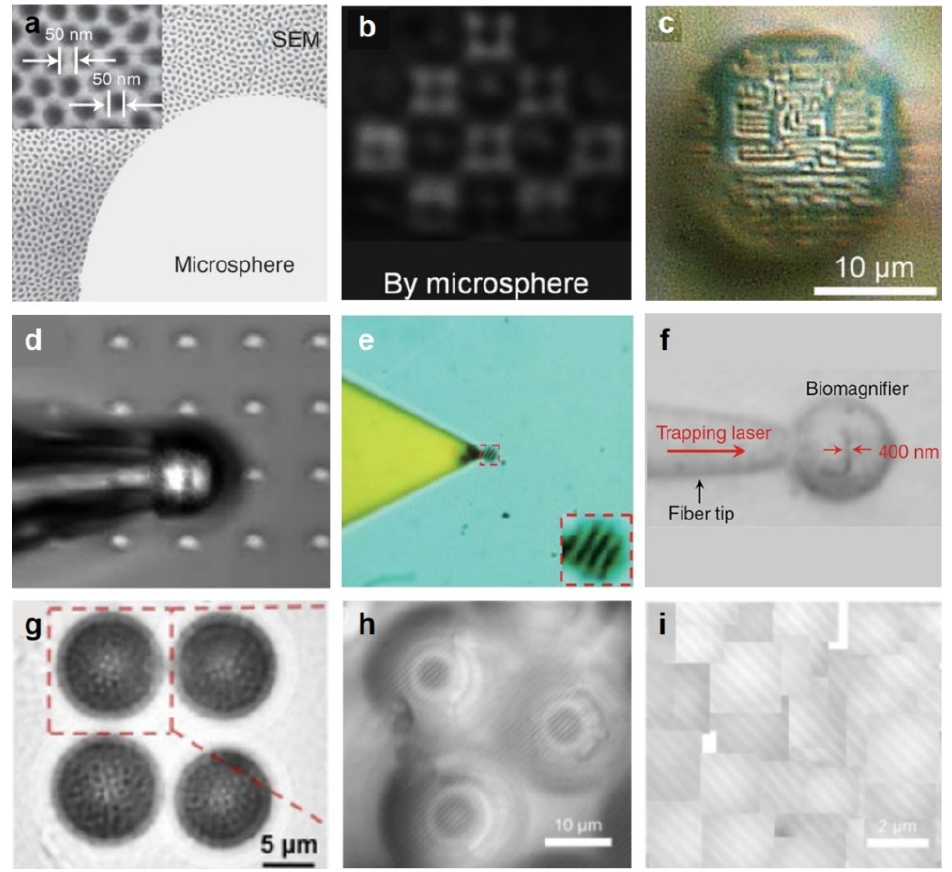
Figure 7. Optical imaging of nanostructures with microspheres. ( a ) SiO 2 microspheres on gold-plated porous anodic aluminum oxide film; ( b ) BaTiO 3 microspheres on nano-plasma samples with a gap of 50–60 nm; ( c ) TiO 2 microsphere superlenses on 60 nm wafers; ( d ) Magnified image of gold splitting square nanostructures imaged using microspheres combined with micropipettes; ( e ) Magnified image of a microsphere combined with an AFM cantilever against a DVD; ( f ) Optical images of nanopatterns trapped on the fiber of a biomagnifier; ( g ) Optical images of PS nanoparticles by a 2 × 2 microlens array; ( h ) Large-area imaging of Blu-ray discs by BaTiO 3 microlenses; ( i ) The Blu-ray disc surface recorded using the random microlens array area imaging superimposed reconstruction mode.